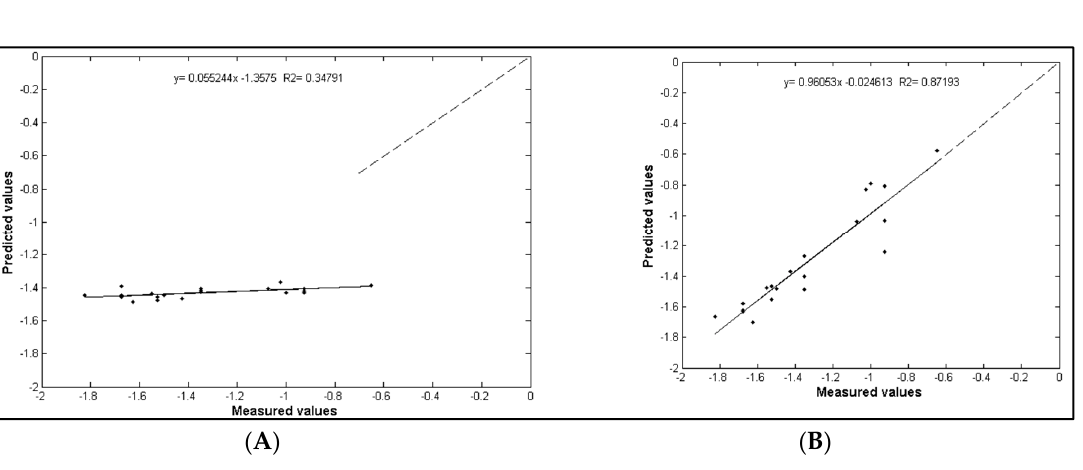
Figure 4. Comparison between estimated and measured values of midday stem water potential (MPa). ( A ) Normalized difference vegetation index (NDVI) ( B ) ANN-2 model.